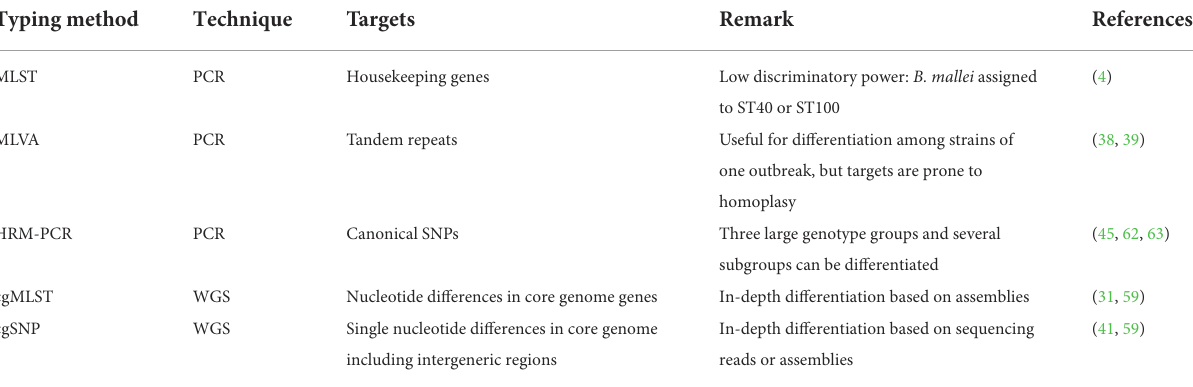
TABLE 3 Most important B. mallei typing techniques and relevant references of the methods or examples for